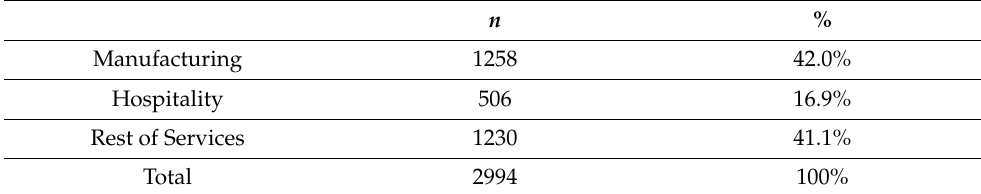
Table 2. Sample distribution.